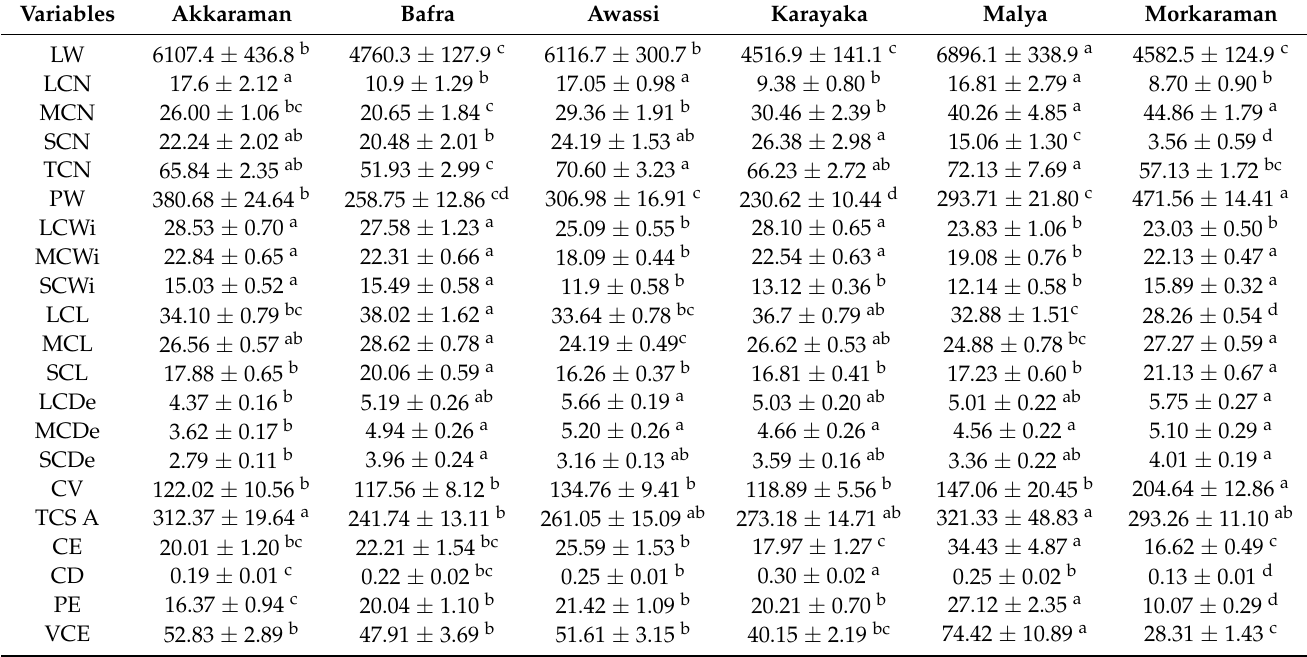
Table 2. Descriptive statistics (Mean ± SEM) of placenta and birth-related traits in Akkaraman, Bafra, Awassi, Karayaka, Malya, and Morkaraman sheep